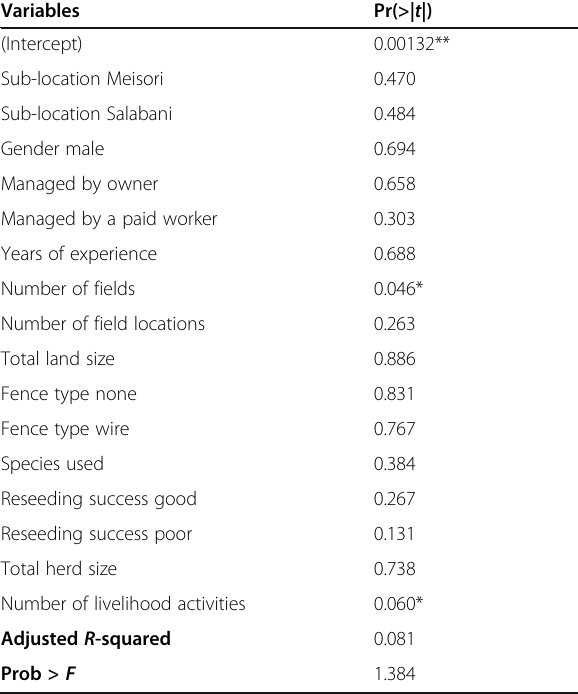
Table 4 Herd survival regression full